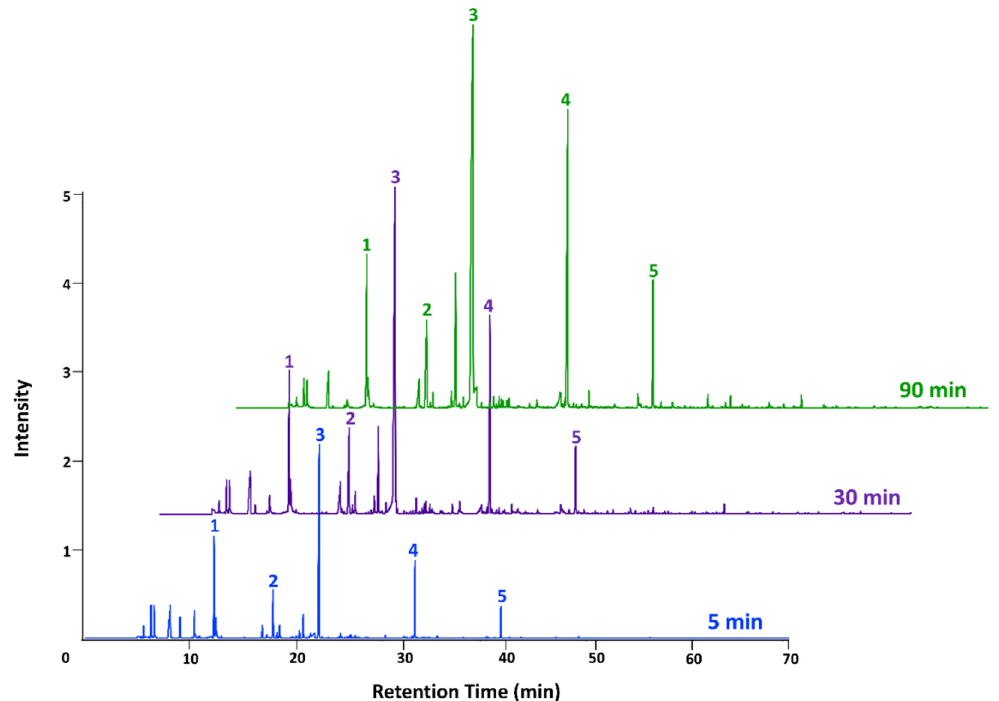
Figure 3. Overlaid chromatograms for one cider sample (EsoTerra Cider) were obtained by headspace solid phase microextraction (HS-SPME) using DVB/CAR/PDMS fibers at 40 °C for various exposure times (5 min: blue, 30 min: purple, 90 min: green) to optimize sampling conditions. The five most abundant and reproduceable peaks were identified and labeled on each chromatogram ( 1: ethyl hexanoate, 2: phenethyl alcohol, 3: ethyl octanoate, 4: ethyl decanoate, and 5: ethyl dodecanoate).